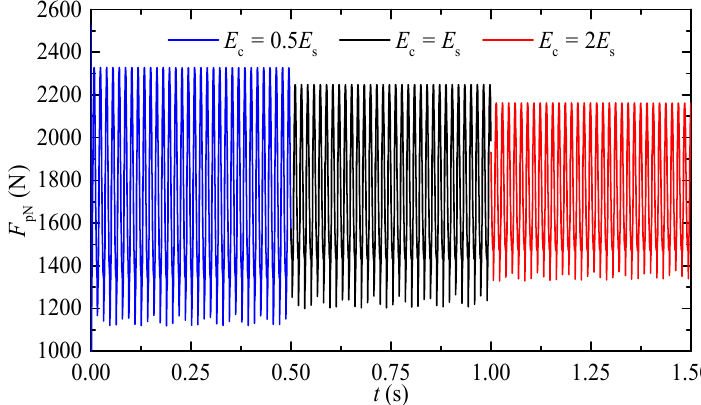
Figure 13. Dynamic meshing forces under different coating elastic moduli.